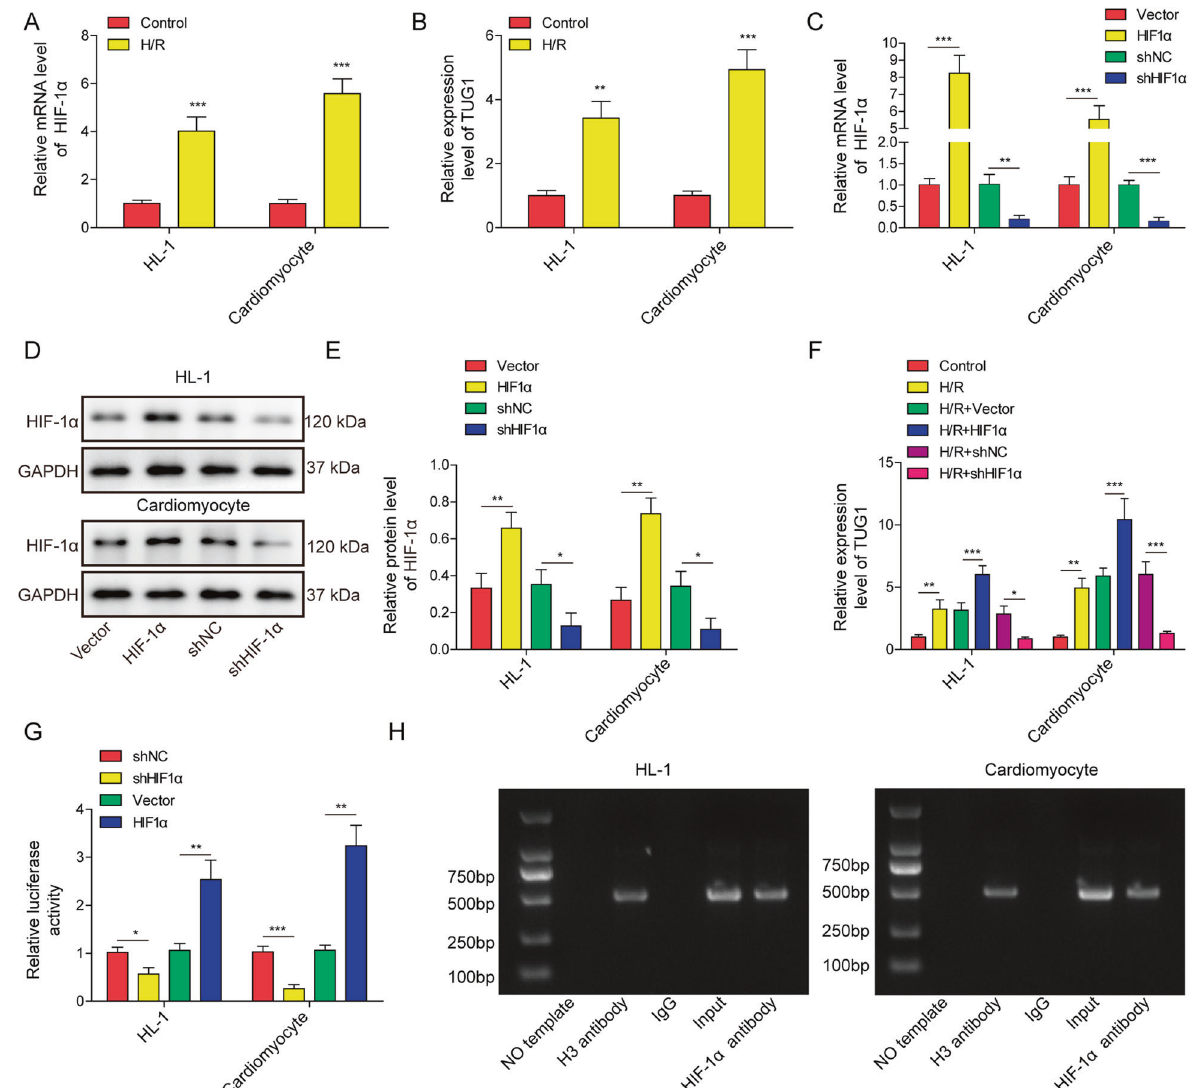
Fig. 2 HIF-1 α increased the expression of TUG1 in cardiomyocytes by binding to its promoter region. qRT-PCR measurement of ( A ) HIF-1 α and ( B ) TUG1 expression in cardiomyocytes treated with H/R. C qRT-PCR and D , E western blot measurement of HIF-1 α expression in cardiomyocytes transfected with shHIF-1 α , shNC, HIF-1 α , or empty vector. F qRT-PCR measurement of TUG1 levels in cardiomyocytes. G Dual luciferase reporter gene assay on the regulation of TUG1 expression by HIF-1 α in cardiomyocytes. H ChIP assay on the presence of TUG1 after pulldown by HIF-1 α antibody in cardiomyocytes. * P < 0.05, ** P < 0.01 and *** P <